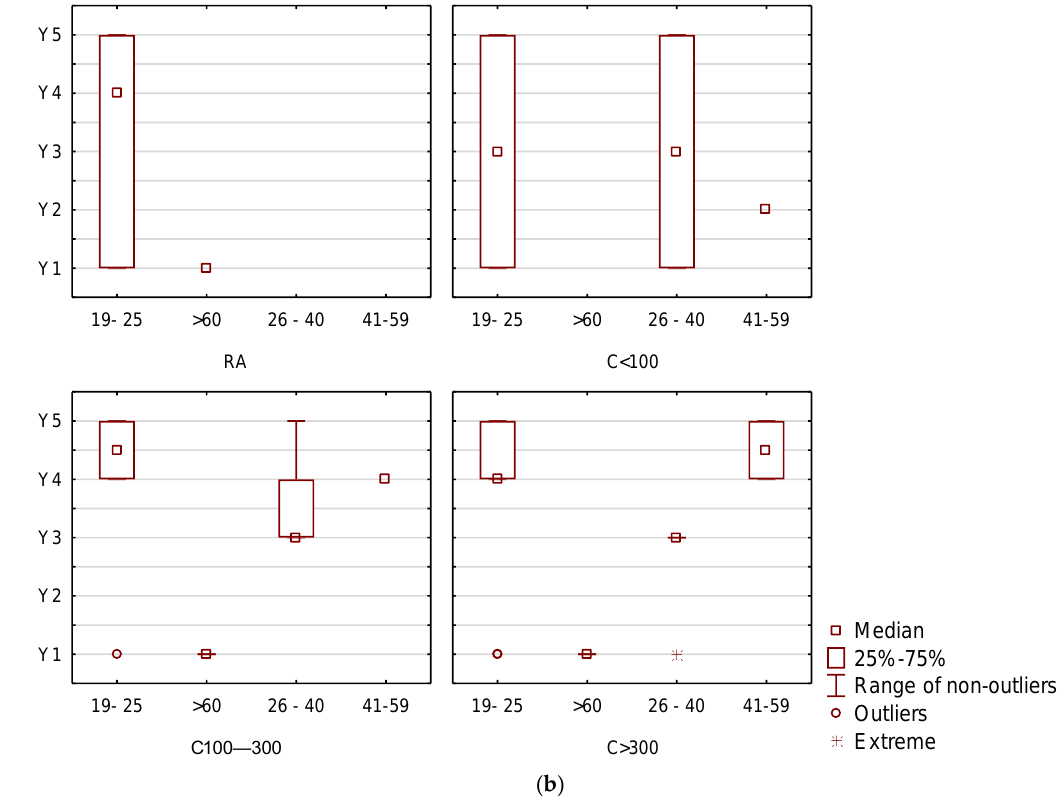
Figure 5. ( a ). Box plots for availability of local products among women ’ s responses by age and place of residence. ( b ). Box plots of local product availability among male responses by age and place of residence. Abbreviations: Y1-hypermarket, Y2-via internet, Y3-local store,